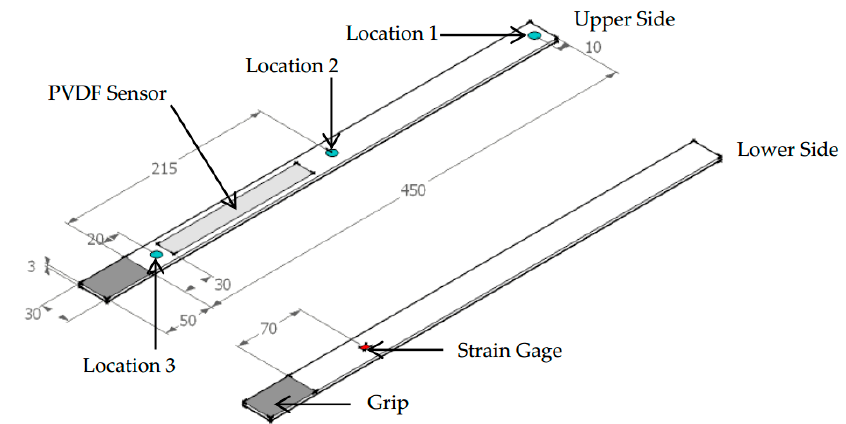
Sensors 2016 , 16 , 601